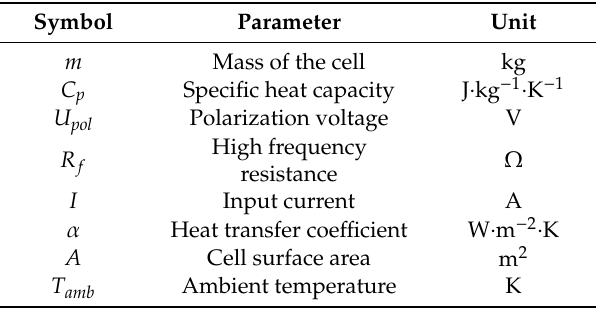
Table 1. Parameters of the thermal